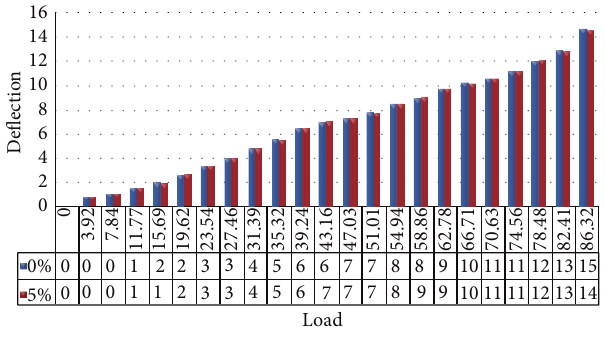
Figure 8: Load versus